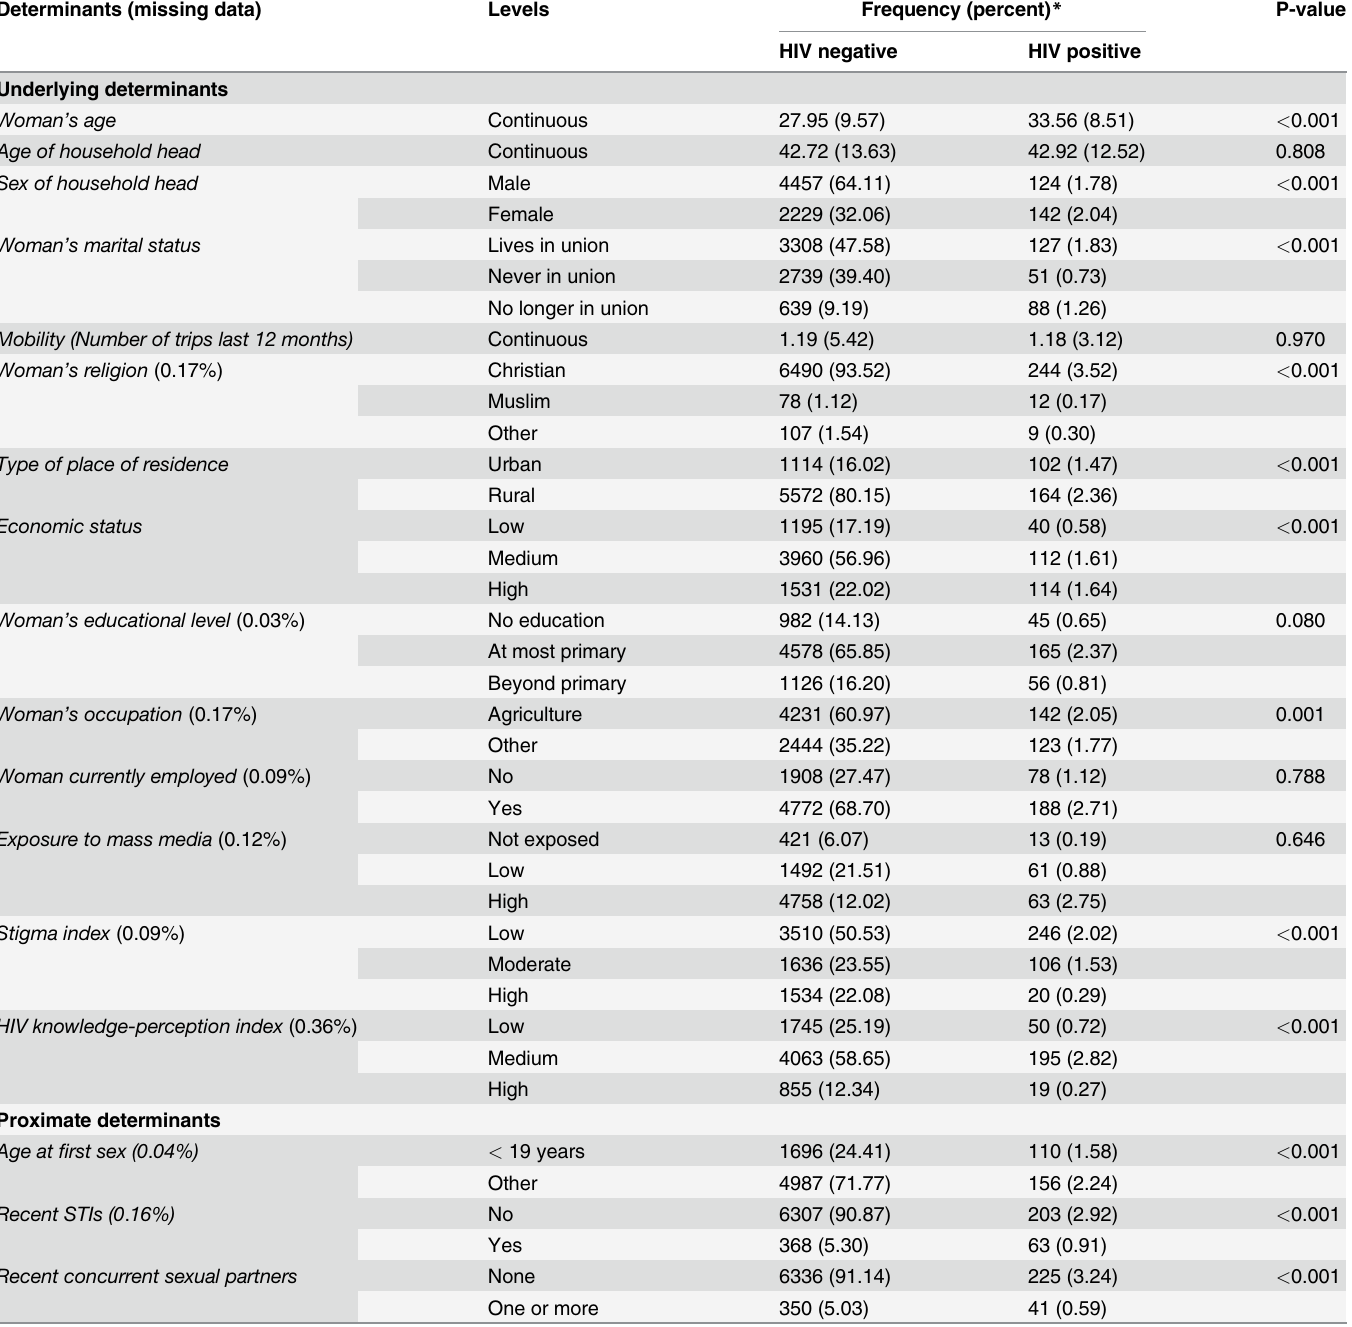
Table 2. Distribution of HIV infection and test of its association with selected factors. Determinants (missing